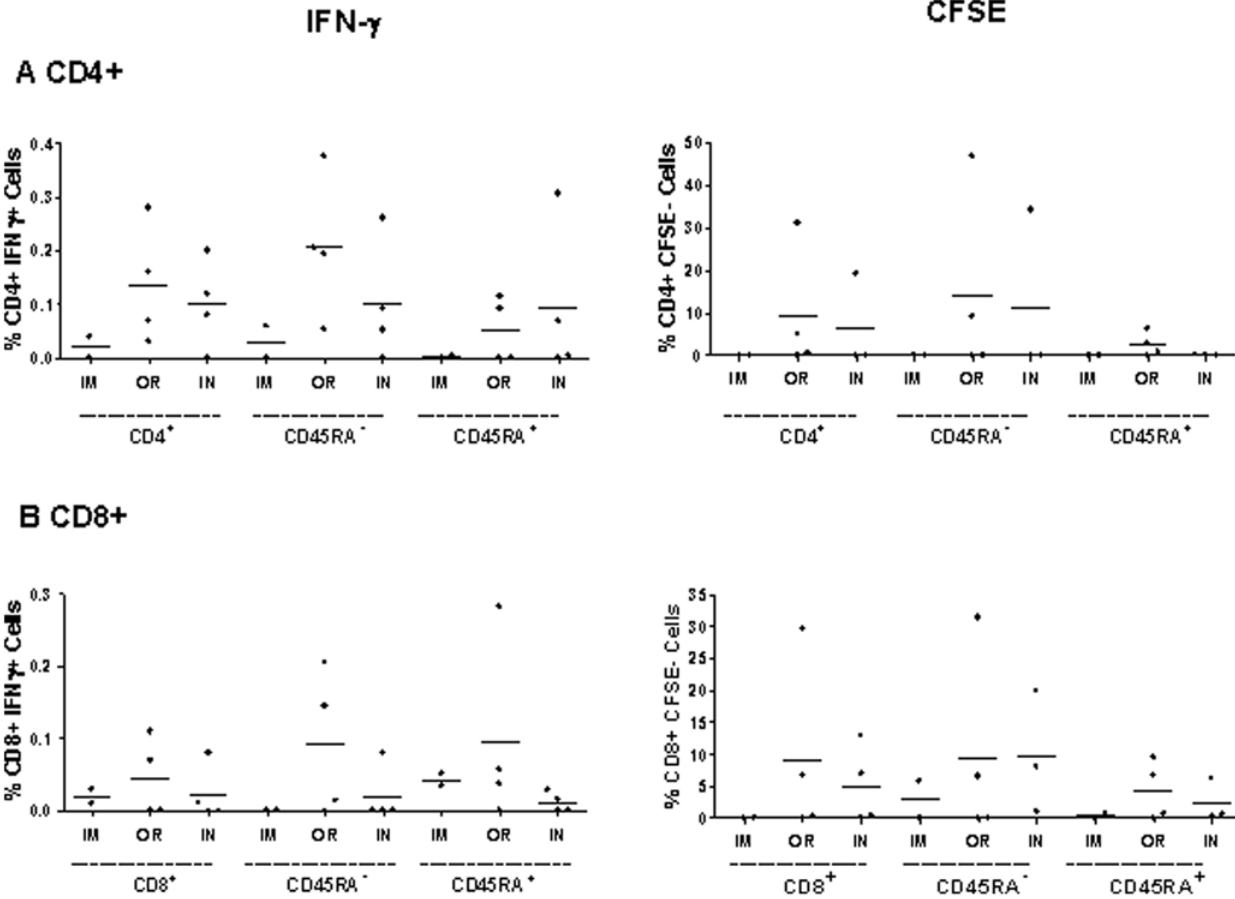
Figure 6. ZEBOVGP-specific CD4 + and CD8 + functional memory responses in PBMCs. Flow cytometry was utilized to evaluate the long term CD4 + (A) and CD8 + (B) ZEBOVGP-specific functional memory responses of freshly isolated PBMCs incubated with media or ZEBOVGP peptides at 6 months post-vaccination. The average for each inoculation route (IM=intramuscular n=2, OR=orally n=4, IN=intranasally n=4) is represented. The CD45RA 2 population denotes the memory lymphocytes, while CD45RA + represents the naı¨ve and effector lymphocytes. The IFN- c response was evaluated after 3 days by intracellular cytokine staining. The background from the media sample was subtracted from the peptide stimulated sample, and the results are shown for each monkey with the average for each group being represented with a bar. The ability of the PBMCs to proliferate in response to the GP peptide was determined by staining the PBMCs with CFSE and then looking for loss of CFSE 6 days later as a measure of proliferation. The percent of CFSE 2 cells for each memory population is shown for each monkey after subtracting the media sample, and the average for each group is represented by a bar.